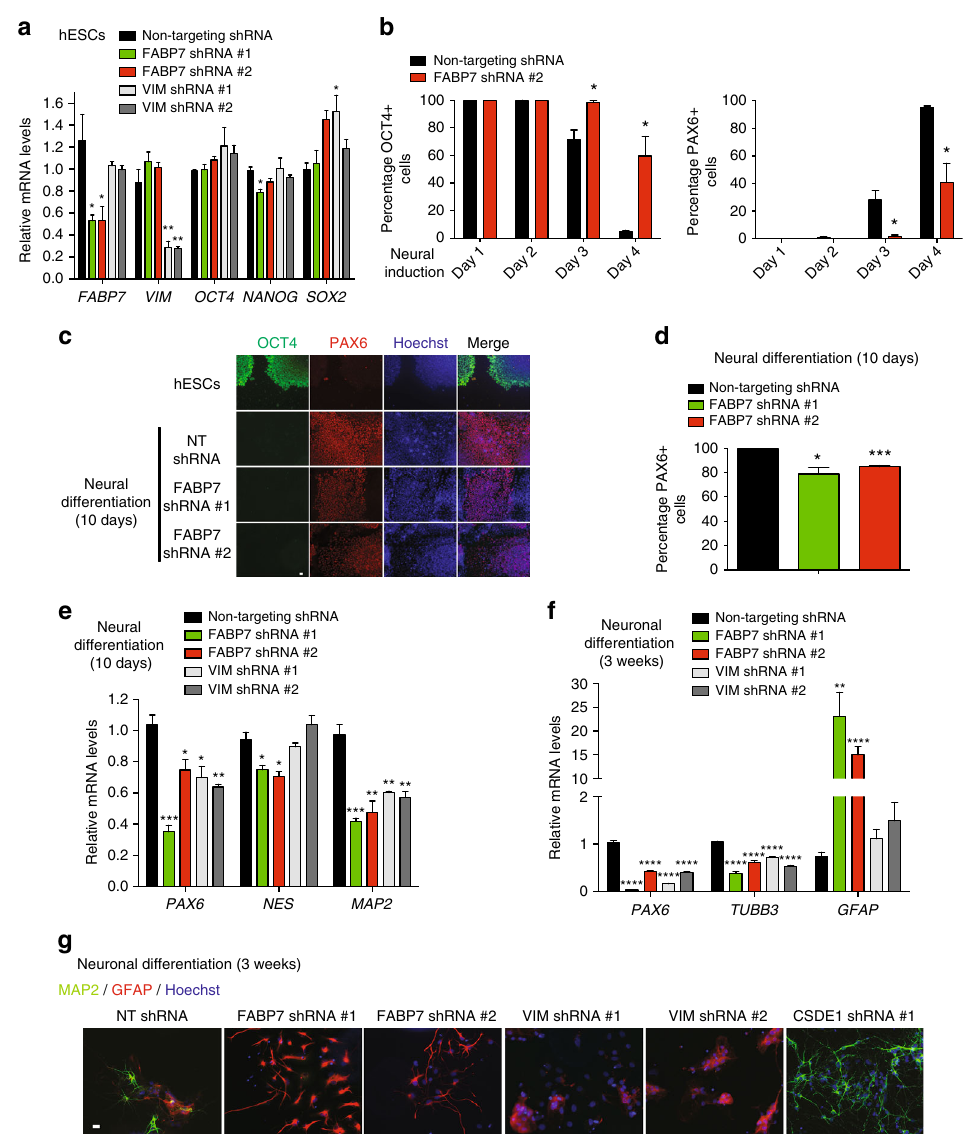
Fig. 6 Loss of FABP7 in hESCs reduces their neural differentiation potential. a qPCR analysis in FABP7 and VIM KD H9 hESCs. Graph (relative expression to NT shRNA H9 hESCs) represents the mean ± s.e.m. of two independent experiments with three biological replicates. b Knockdown of FABP7 slows down neural differentiation. Percentage of OCT4 and PAX6-positive cells/total nuclei at different days after neural induction of H9 hESCs (mean ± s.e.m. ( n = 3, 400 – 650 total cells per data point). c After 10 days of neural induction, cells were assessed by immuno fl uorescence with OCT4, PAX6, and Hoechst staining. Scale bar represents 20 μ m. d Quanti fi cation of the percentage of PAX6-positive cells/total nuclei after 10 days of neural induction. Graph represents the mean ± s.e.m. of 3 independent experiments, 3000 total cells per experiment. e qPCR analysis after 10 days of neural induction. Graph (relative expression to NT shRNA cells) represents the mean ± s.e.m. of three independent experiments. f qPCR analysis after 3 weeks of neuronal induction. Data (relative expression to NT shRNA cells) represent the mean ± s.e.m. of three independent experiments with three biological replicates. g After 3 weeks of neuronal induction, cells were assessed by immuno fl uorescence with MAP2, GFAP, and Hoechst staining. Scale bar represents 20 μ m. All the statistical comparisons were made by Student ’ s t-test for unpaired samples. P -value: *( P < 0.05), **( P < 0.01), ***( P < 0.001), **** ( P <